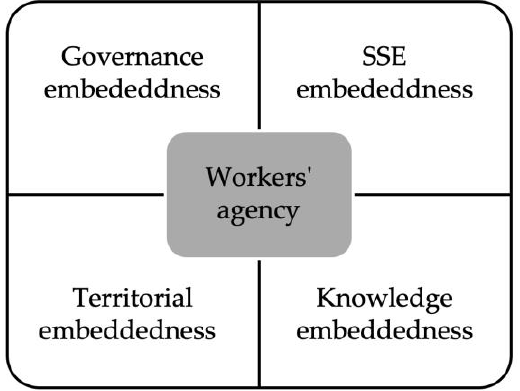
Figure 1. The embeddedness of platform cooperatives.